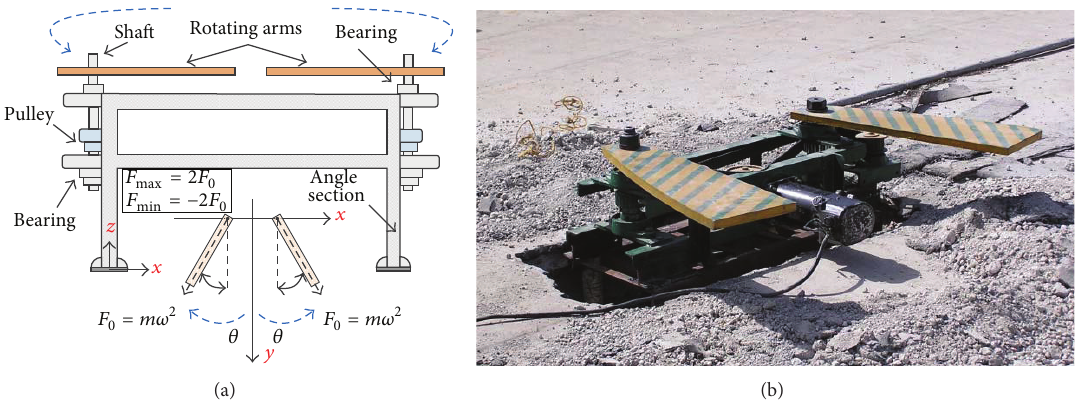
Figure 4: Designed shaker: (a) layout and theory of the shaker, (b) general view under the operation.